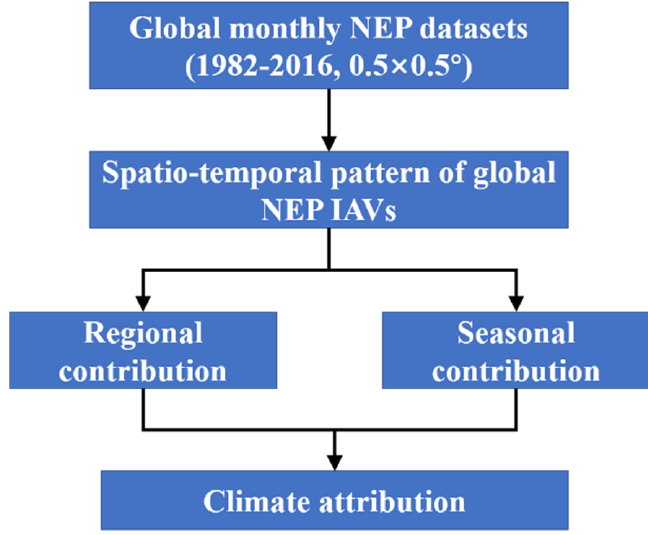
Figure 2. The flowchart of the study.